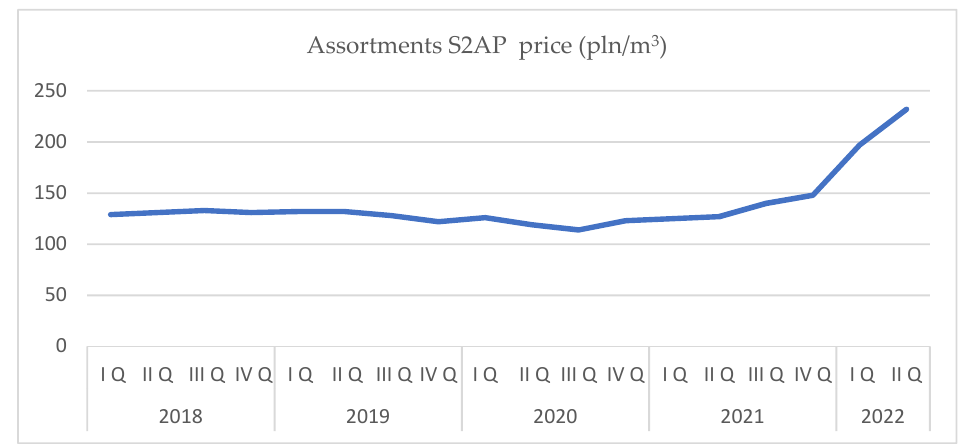
Figure 6. Prices for the S2AP assortment at quarterly intervals in years 2018–2022. Source: Own elaboration based on data obtained from the State Forests IT System (SILP). Table 3. Price forecast for the S2AP assortment for Q3 of 2022, Q4 of 2022, and Q1 of 2023. Source: Own elaboration based on data obtained from the State Forests IT System